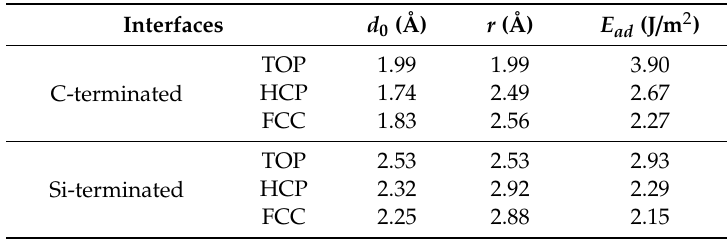
Table 1. Equilibrium interface distances d 0 (Å), C (Si)-Al bonds r (Å) and the ideal adhesion energies E ad (J / m 2 ) at the Al (111) / SiC (0001)